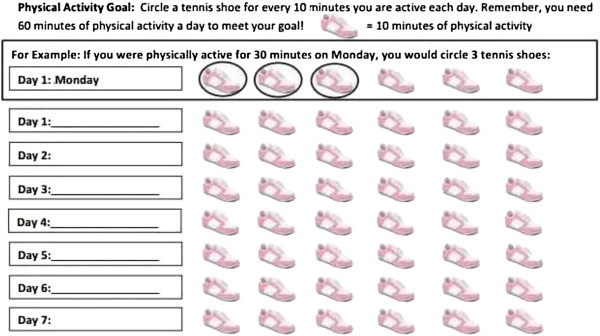
PA tracking sheet.